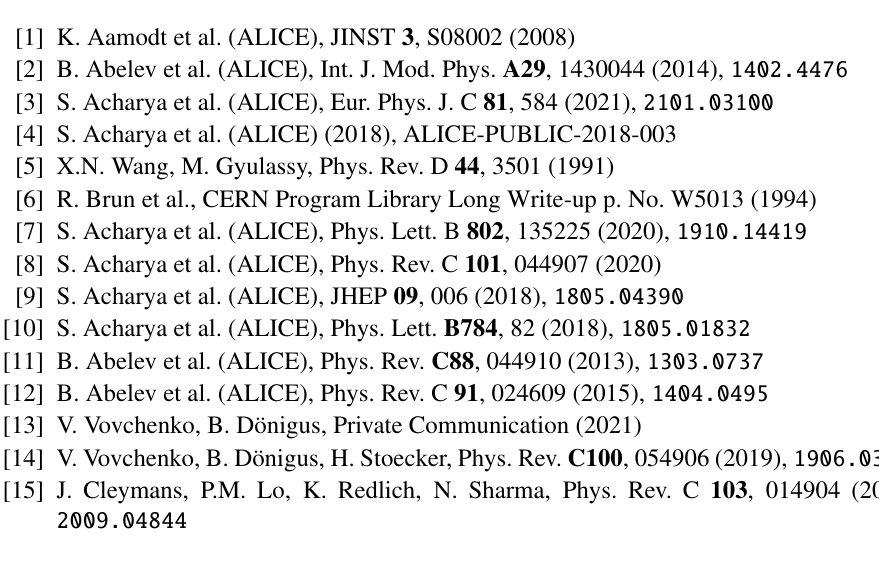
does not depend significantly on the collision system and scales with the charged particle